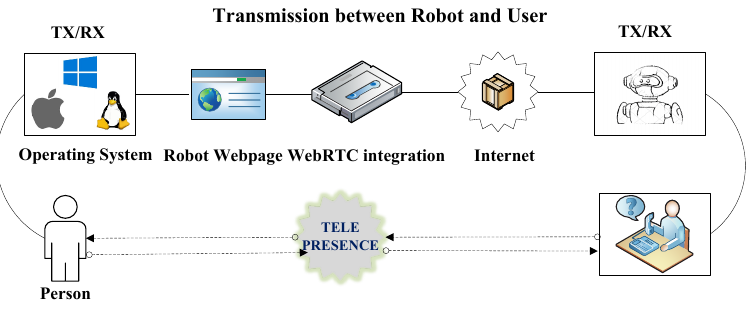
Figure 8. Complete sequence of WebRTC, Javascript signalizing API implementation.